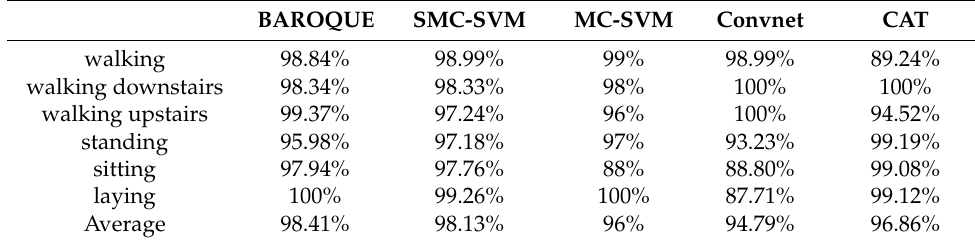
Table 6. Classification accuracies of different HAR solutions using the UCI-HAR